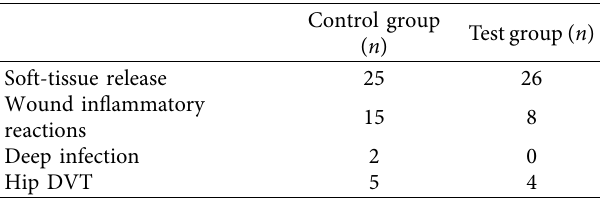
Table 3: Intraoperative and postoperative outcome measures of the two